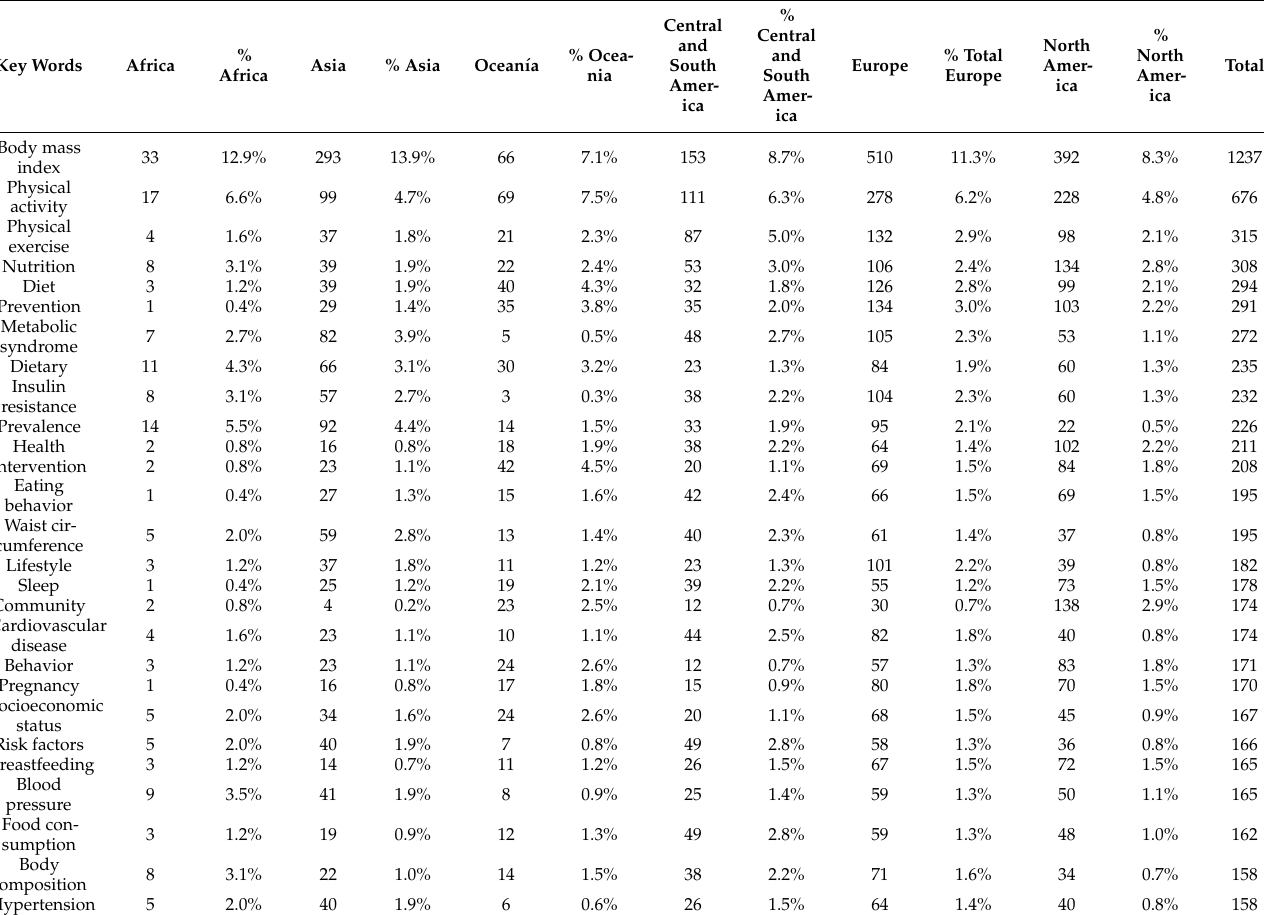
Table 5. Most frequent keywords per continent.